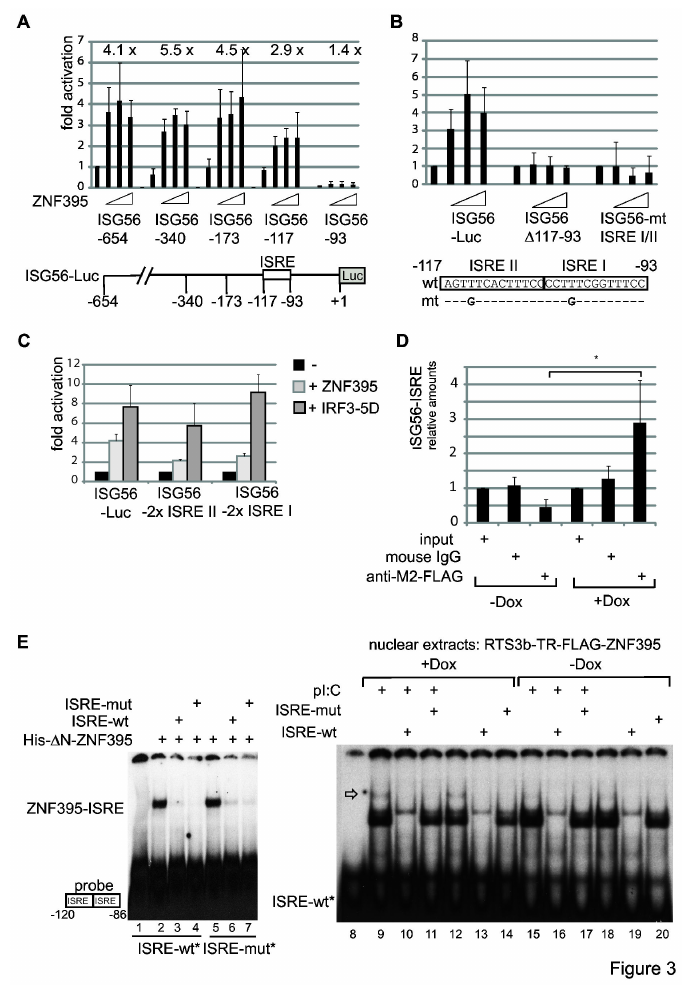
Figure 3. ZNF395 acts through ISREI and ISREII to stimulate the ISG56 promoter. ( A ) Sequential deletions starting from the 5´ end of the ISG56 upstream regulatory region were introduced into the ISG56-Luc construct as indicated in the figure. The corresponding luciferase reporter constructs were co-transfected with 5, 10 and 20ng of the FLAG-ZNF395 expression vector. The relative luciferase activity of the full length ISG56-Luc (=ISG56-654) construct was set as 1. The numbers above each set represent the fold activations induced by ZNF395 with the relative activity of each mutated reporter construct set as 1. ( B ) The construct ISG56Δ117-93 contains a deletion of the two ISREs within the context of the full length ISG56-Luc construct which harbors the upstream region up to -654bp while in ISG56-mtISRE I/II a T in each ISRE has been changed into G, as indicated beneath the graph. All reporter constructs were co-transfected again with 5, 10 or 20ng of the expression vector for FLAG-ZNF395. The sequence of the two ISREs present in the ISG56 promoter with the point mutations that have been introduced is provided. ( C ) Transient transfections with ISG56-Luc reporter constructs that were modified to contain either two copies of ISRE I (ISG56-2x ISRE I) or two copies of ISRE II (ISG56-2x ISRE II) and 5ng of expression vector for ZNF395 or IRF3-5D, respectively. ( D ) ChIP-assay. RTS3b-TR-FLAG-ZNF395 cells were grown in the absence or presence of Dox, cross-linked and subjected to a ChIP assay with antibody against the FLAG-tag and control mouse IgG. The precipitated DNA segments were amplified with a LightCycler using primers flanking the ISREs of the ISG56 promoter. The ISG56-Luc reporter construct was included as standard to allow a quantification. The copy number obtained for the input was set as one for each extract and the fold enrichment was calculated. The PCRs were performed in triplicate (* p=0.05). ( E ) Gel shift analysis. Bacterially expressed his-tagged purified ΔN-ZNF395 (lacking amino acids 1-114) was incubated with 200pg ISREI-wt (lanes 1-4) or ISRE-mut oligonucleotide (lanes 5-7), both radioactively labeled with 32 P-γ-ATP and the binding was analyzed with a native PAA gel. In lanes 3 and 6, a 250-fold excess of unlabeled ISRE- wt and in lanes 4 and 7, of ISRE-mut oligonucleotide were added as competitors. In the gel shift shown on the right, nuclear extracts incubated with labeled ISRE-wt oligonucleotide and a 250-fold excess of unlabeled ISRE-wt or ISRE-mut oligonucleotide. The position of the putative ZNF395-ISRE complex is indicated by an